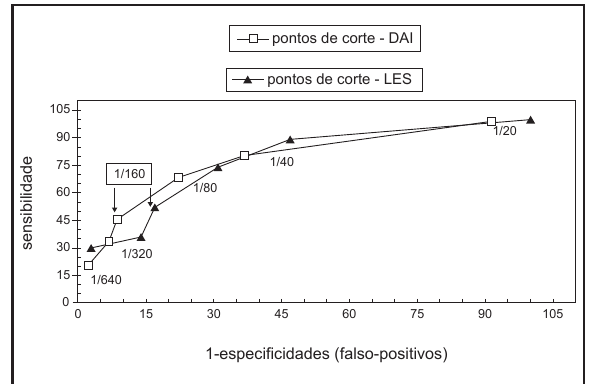
Figura – Curva ROC para determinação do ponto de corte para diagnóstico de LES e doença autoimune  : Títulos (diluições) utilizados como pontos de corte. ROC: receive operator caracteristic curve ; LES: lúpus eritematoso sistêmico; DAI: doença